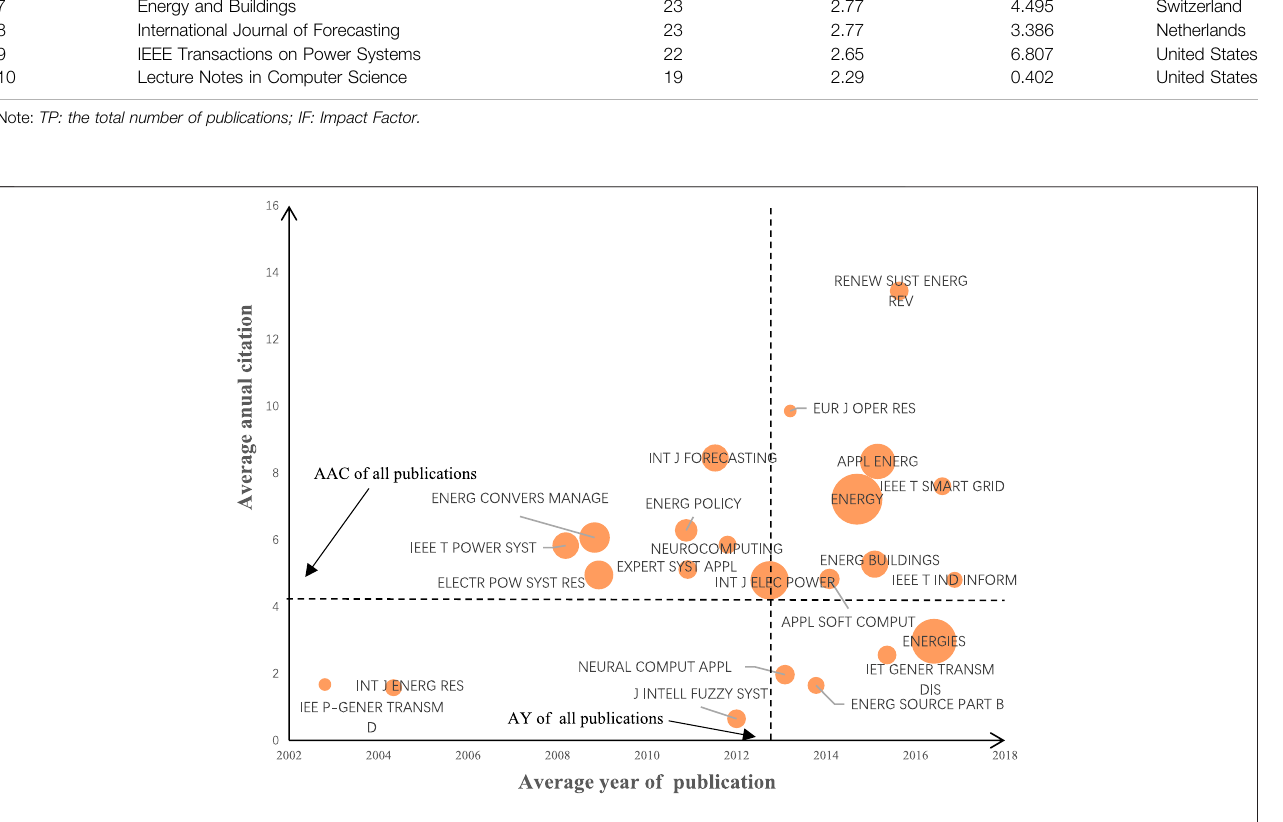
FIGURE 4 | Distribution of main journals in electricity demand forecasting, 1999 – 2018.